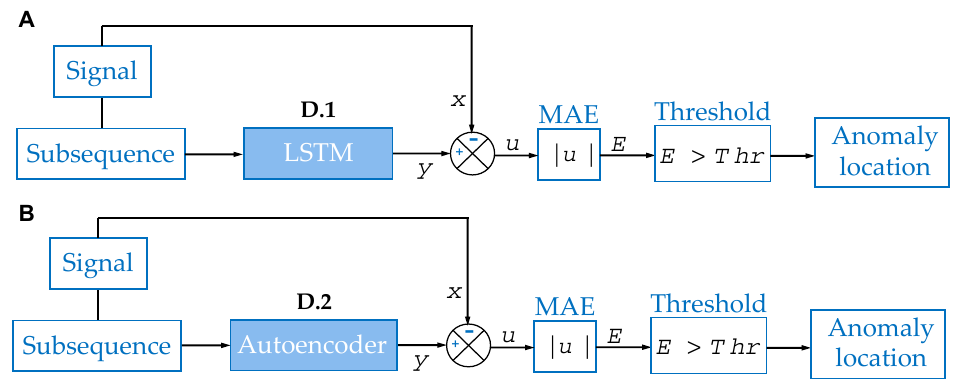
Figure 3. Anomaly detectors based on deep learning. ( A ) Anomaly detector based on an LSTM network. ( B ) Anomaly detector based on an autoencoder.